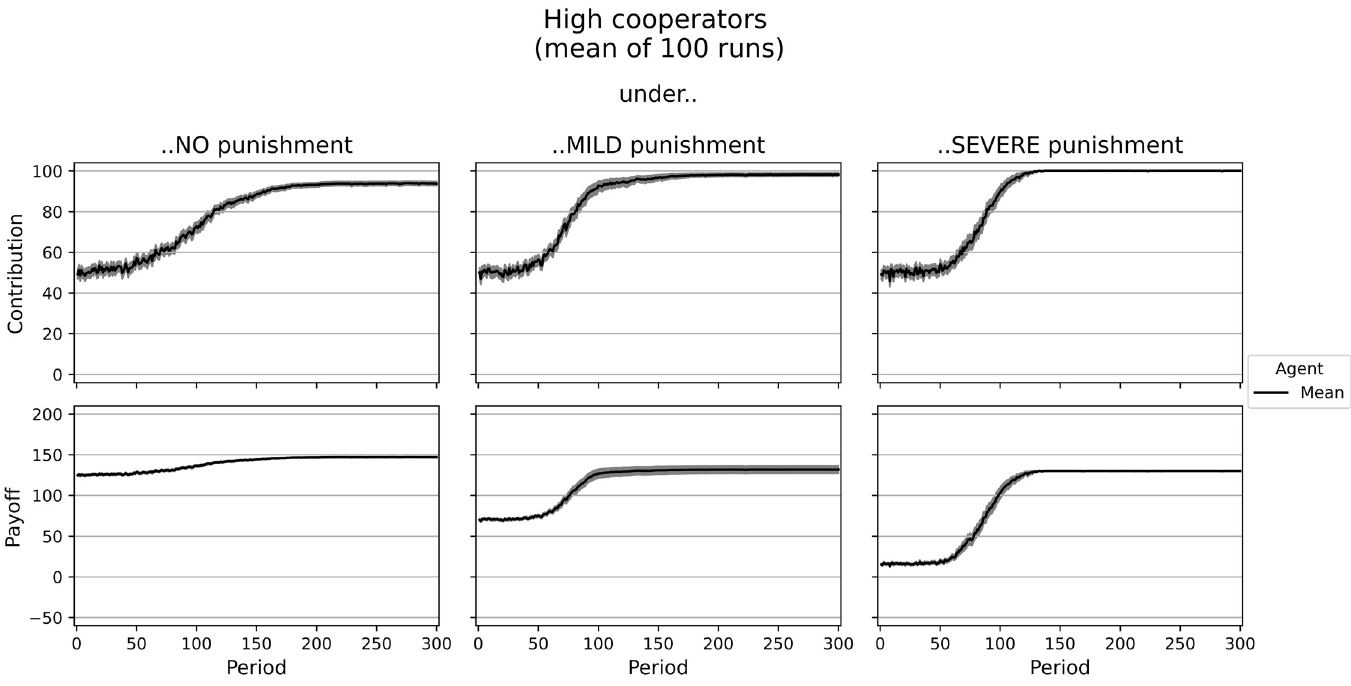
Fig 3. Dynamics of contributions and payoffs of high cooperators under no, mild, and severe punishment. Arithmetic mean of 100 simulation runs. In gray: confidence interval (95%) around the mean.